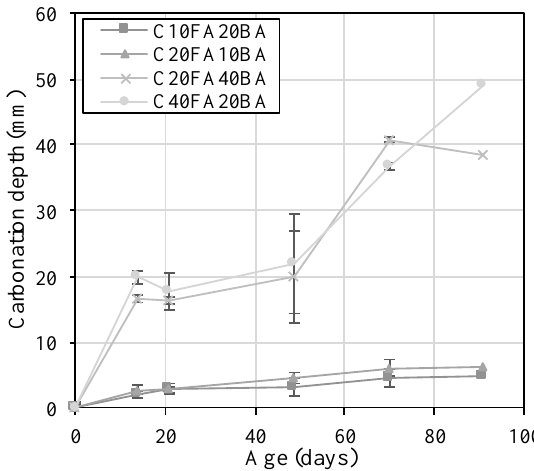
Figure 10. Carbonation depth of samples with MIBA.